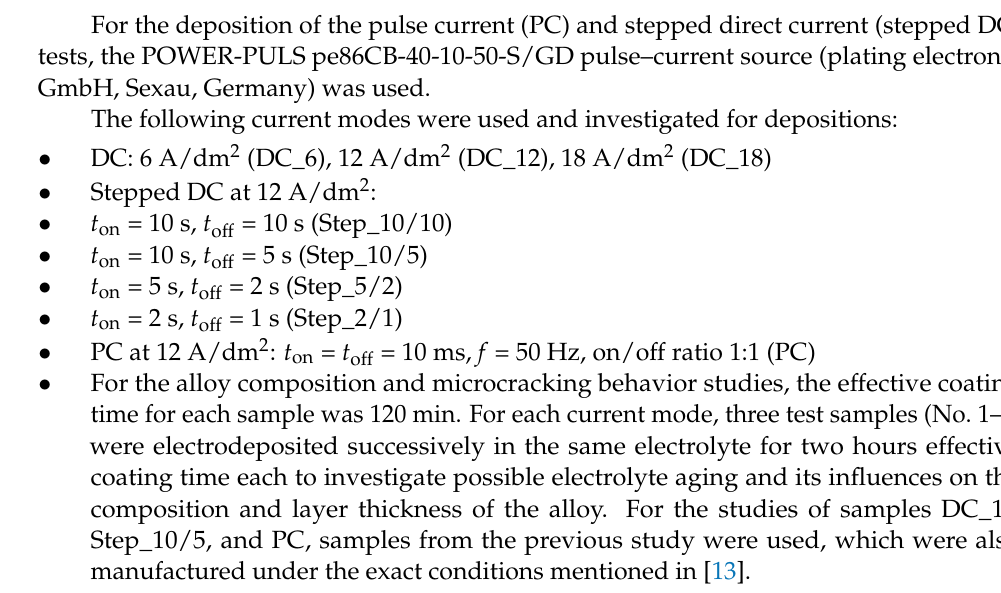
Figure 1. Experimental setup and sample geometry of the in situ pH measurement during the electrodeposition